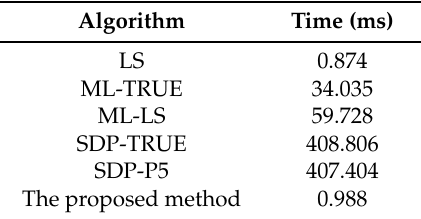
Table 2. The average running time of the considered